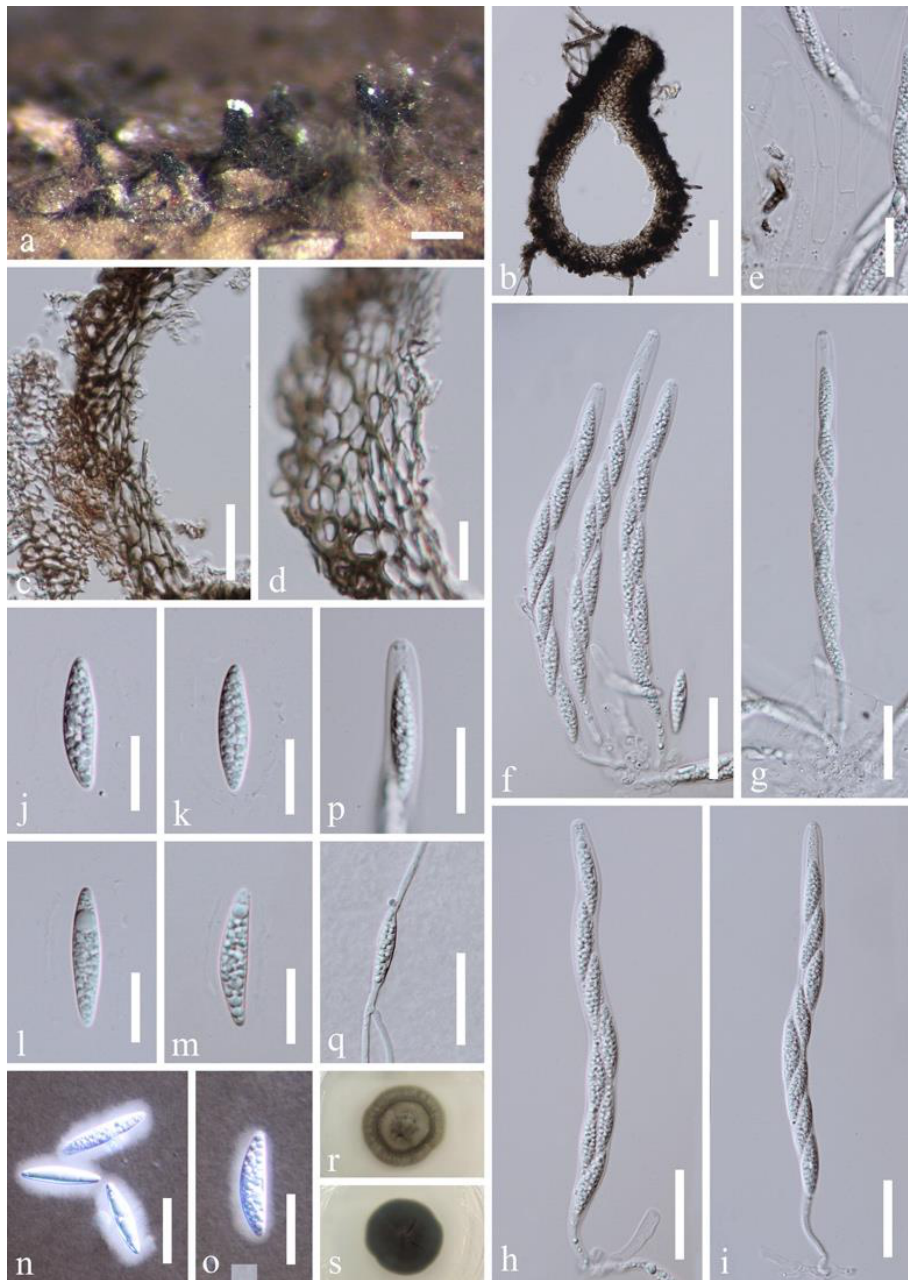
Figure 6. Distoseptispora hyalina (MFLU 21-0137, holotype). ( a ) Ascomata on woody substrate. ( b ) Vertical section of an ascoma. ( c ) Section of the bottom wall. ( d ) Section of the lateral wall near the beak. ( e ) Paraphyses. ( f – i ) Asci. ( j – o ) Ascospores, n and o using Indian ink. ( p ) Apical ring. ( q ) Germinated spore. ( r , s ) Culture, r from above, s from below. Scale bars: ( a ) 200 μm, ( b ) 50 μm, ( f – i , q ) 30 μm, ( c , e , n , p ) 20 μm, ( j – m , o ) 15 μm, ( d ) 10 μm. Distoseptispora lignicola D.F. Bao, Z.L. Luo, H.Y. Su, and K.D. Hyde, Fungal Diversity 99: 487 (2019) Figure 7. Index Fungorum number: IF555641, Facesoffungi number: FoF05413 Cultural characteristics: conidia germinating on WA within 24 h and germ tube pro- duced from both ends. Colonies on PDA reaching about 30 mm diam. after 3 weeks at 25 °C in dark, circular, with dense, velvety, whitish brown mycelium on the surface, uneven in the middle; in reverse dark brown at the entire margin, rimous in the middle.